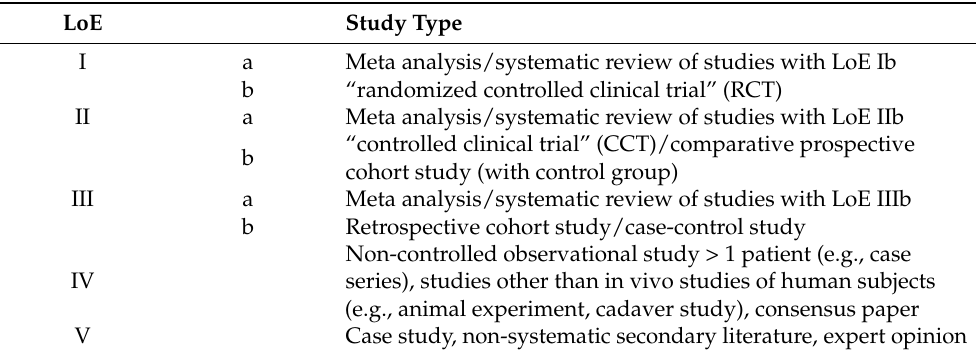
Table 1. Level of Evidence based on Oxford criteria 2009 [18].